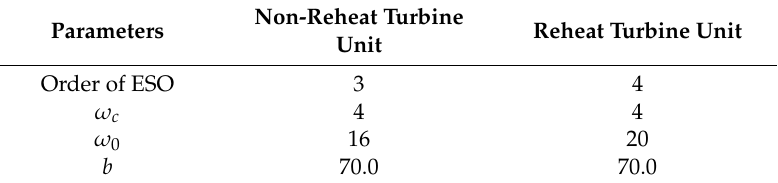
Table A2. ADRC parameters.